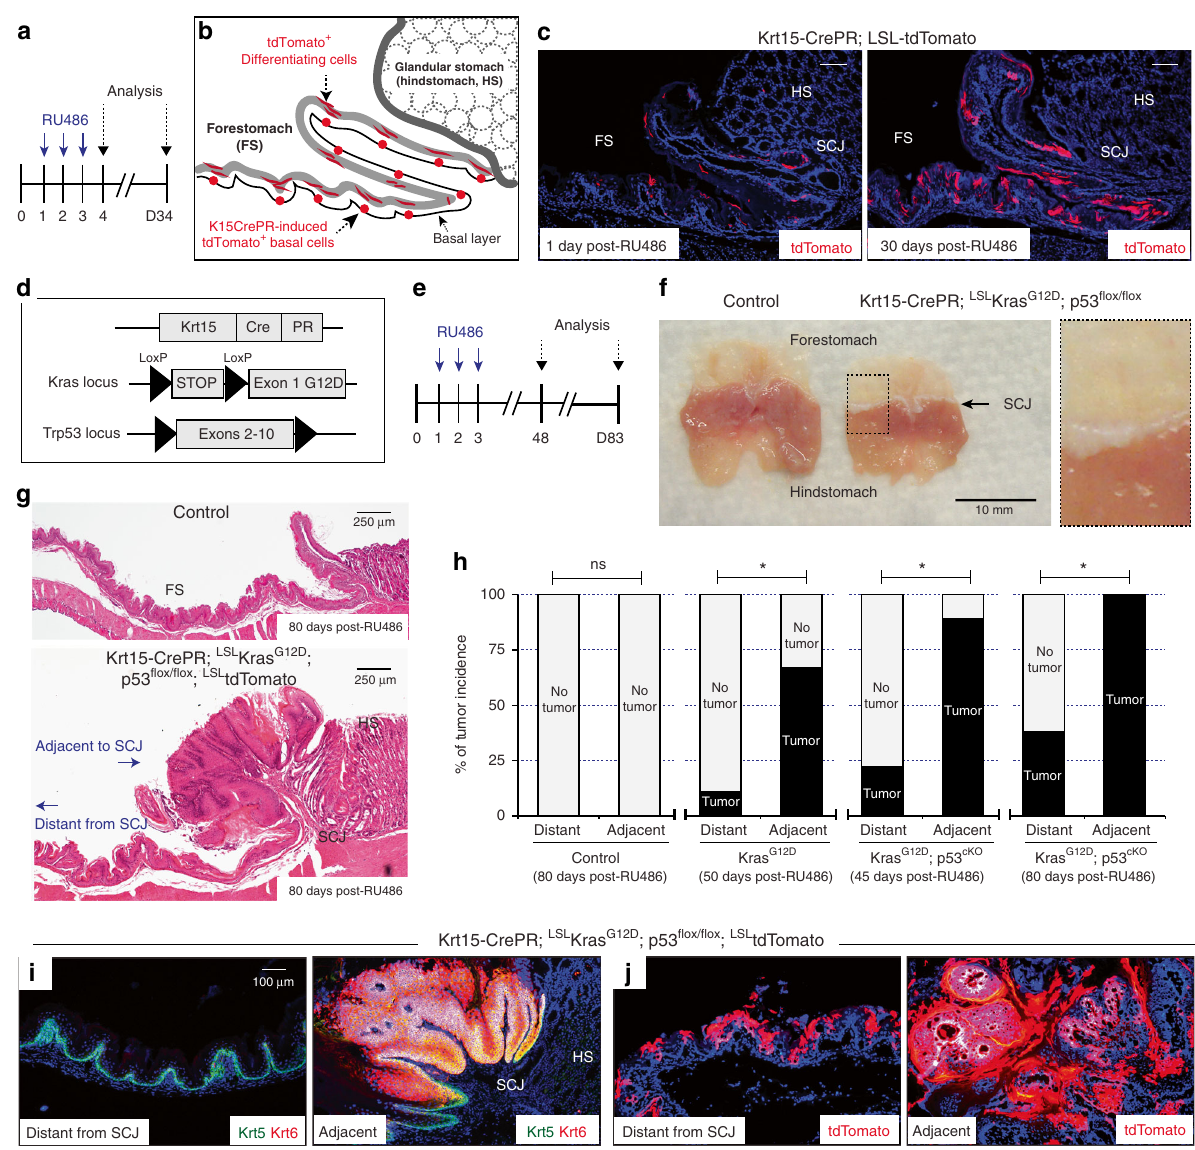
Fig. 2 Higher susceptibility of tumor development from Keratin15 + (Krt15 + ) progenitors near the SCJ. a Experimental scheme. b , c tdTomato-positive Krt15 + progenitors and their differentiated daughter cells, scale bar 100 µ m. d , e Experimental scheme. f , g Macroscopic and histological phenotype of Ras/ p53-mediated tumor formation throughout the regions adjacent to SCJ. Scale bars, 250 µ m. h Tumor incidence from tumor-competent Krt15 + progenitors. Control, n = 9 animals. Krt15-CrePR; LSL-Kras G12D , n = 9 animals. Krt15-CrePR; LSL-Kras G12D ; p53 fl ox/ fl ox (45 days, n = 9 animals; 80 days, n = 8 animals). Statistical signi fi cance was determined by Fisher ’ s exact test; ns = not signi fi cant, * p < 0.05. i , j Immunostaining for Krt5 and Krt6, and tdTomato lineage tracing demonstrated signi fi cant tumor formation from tumor-competent Krt15-CrePR + progenitors resident at the region adjacent to SCJ. Scale bar, 100 µ m. FS, forestomach; HS, hindstomach; SCJ, squamocolumnar